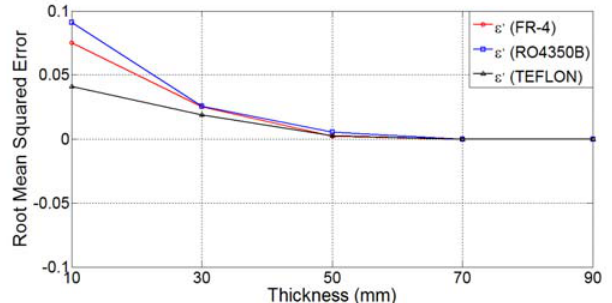
Figure 10: Root mean squared error versus thickness graph for .